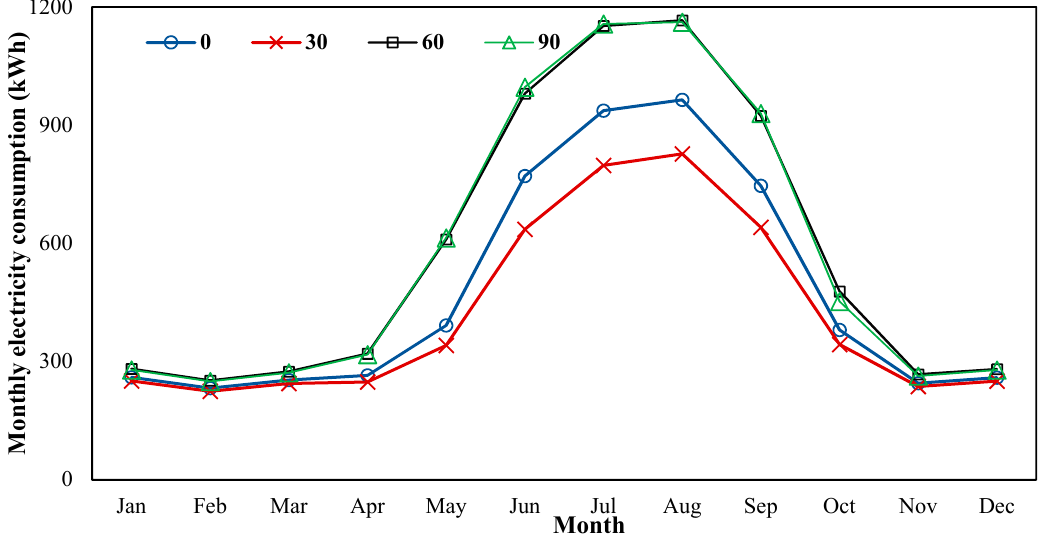
Figure 7. Monthly natural gas consumption for different building orientations (°).